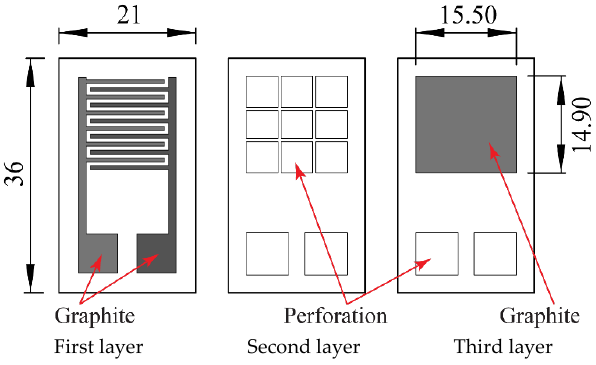
Figure 2. Three main layers of the sensor.